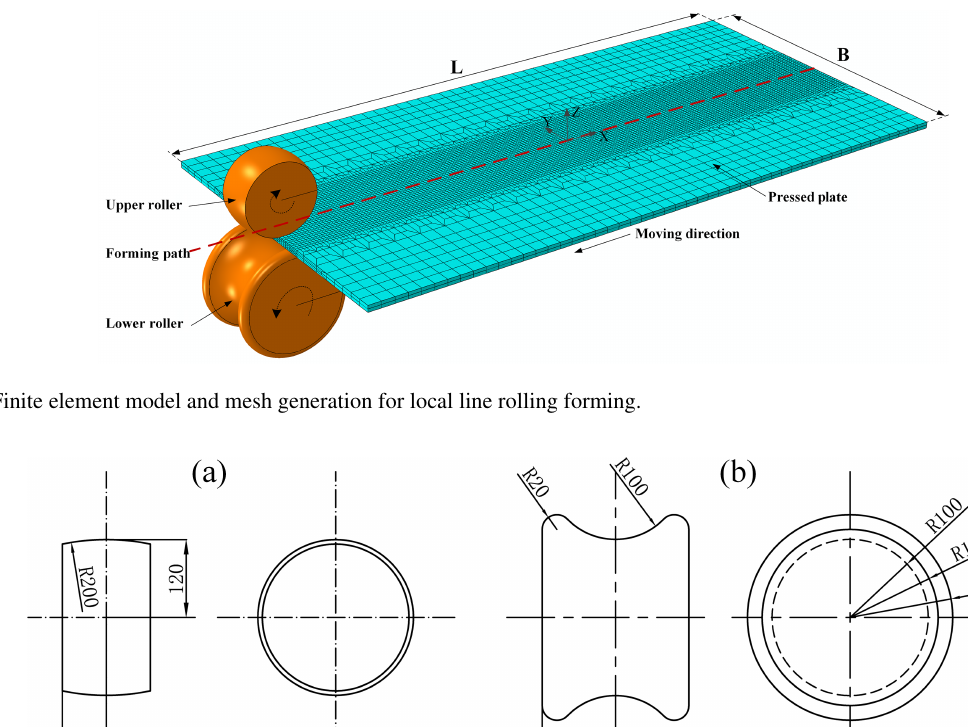
3 Model and results of elastoplastic finite element